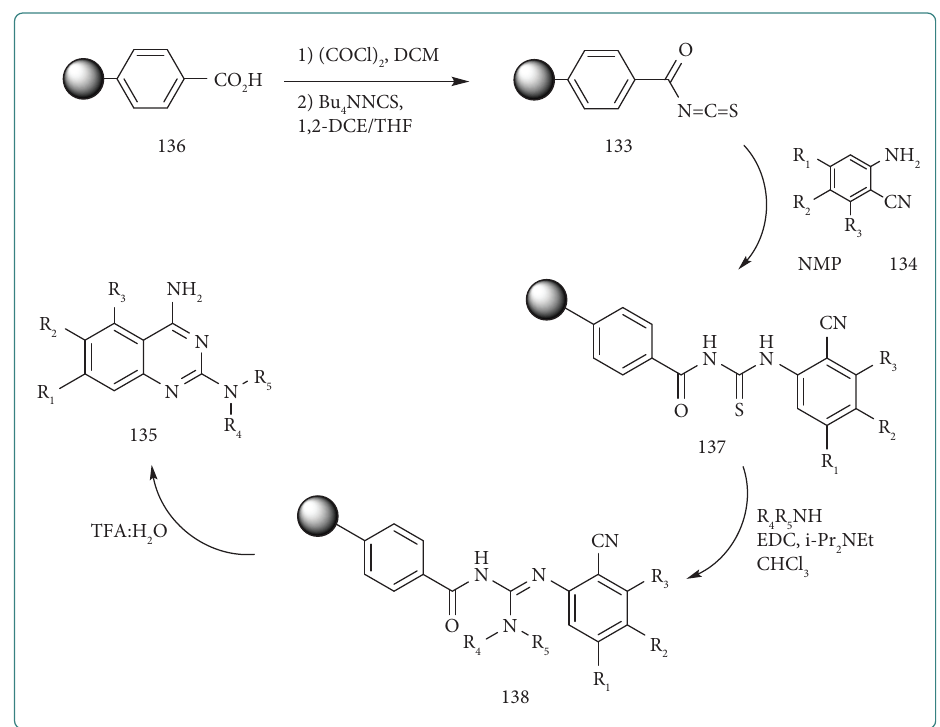
Figure 16: Te proposed mechanism for the synthesis of 2,4-diaminoquinazolines using acyl isothiocyanate